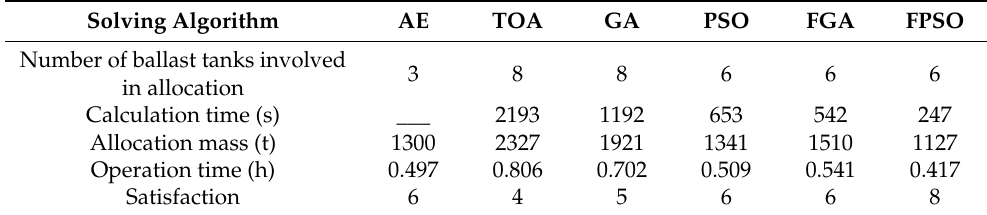
Table 4. Calculation results of different solving algorithms for the RFC with eight ballast